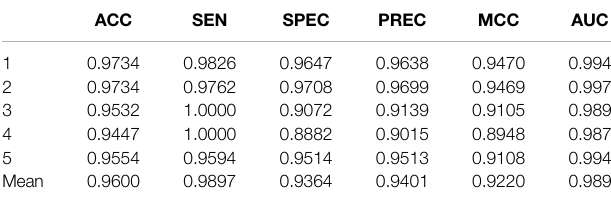
TABLE 2 | Results of 5-fold cross-validation.